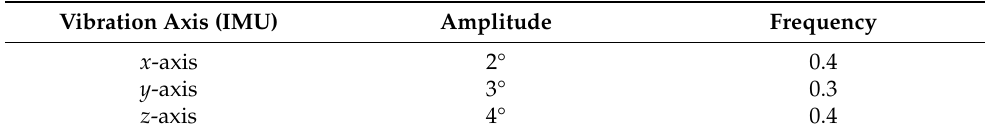
Table 2. Vibration patterns.